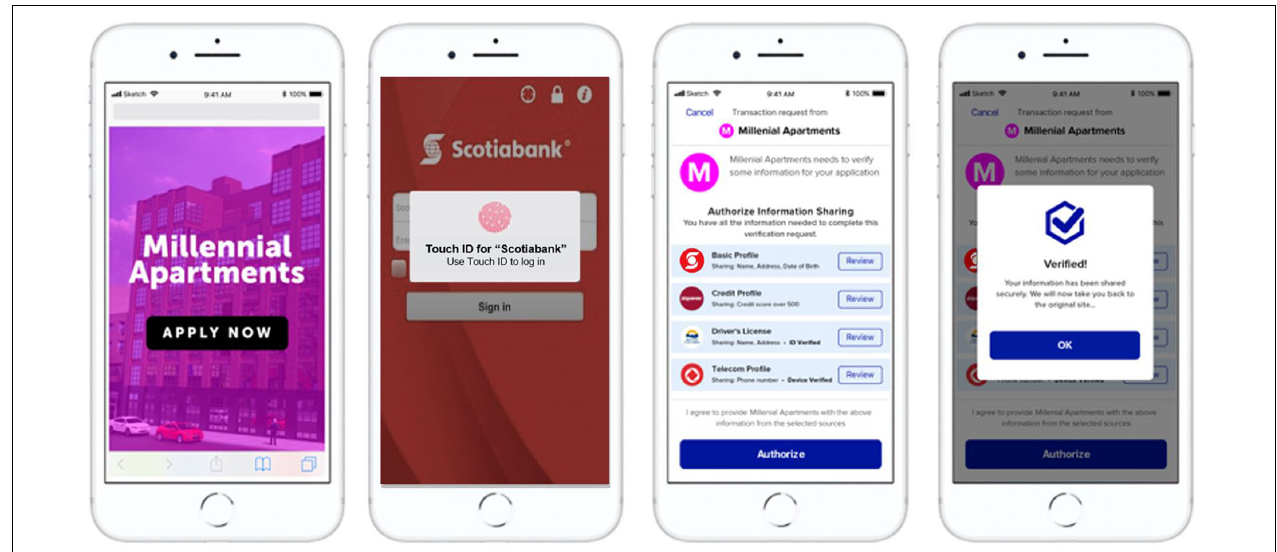
FIGURE 2 | The screens a user will see while accessing Verified.Me to verify their